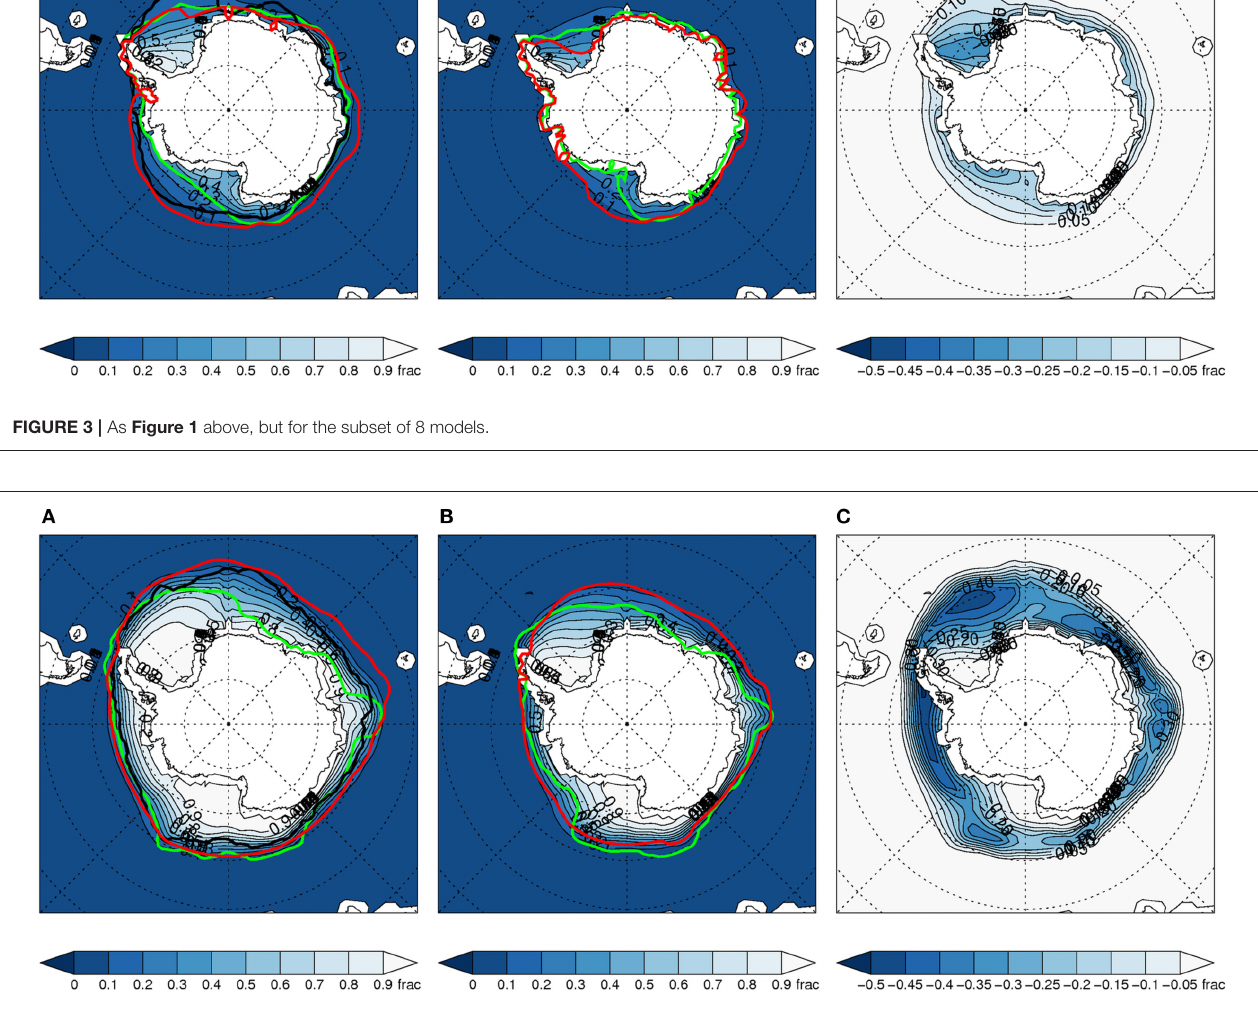
FIGURE 4 | As Figure 2 above, but for the subset of 8